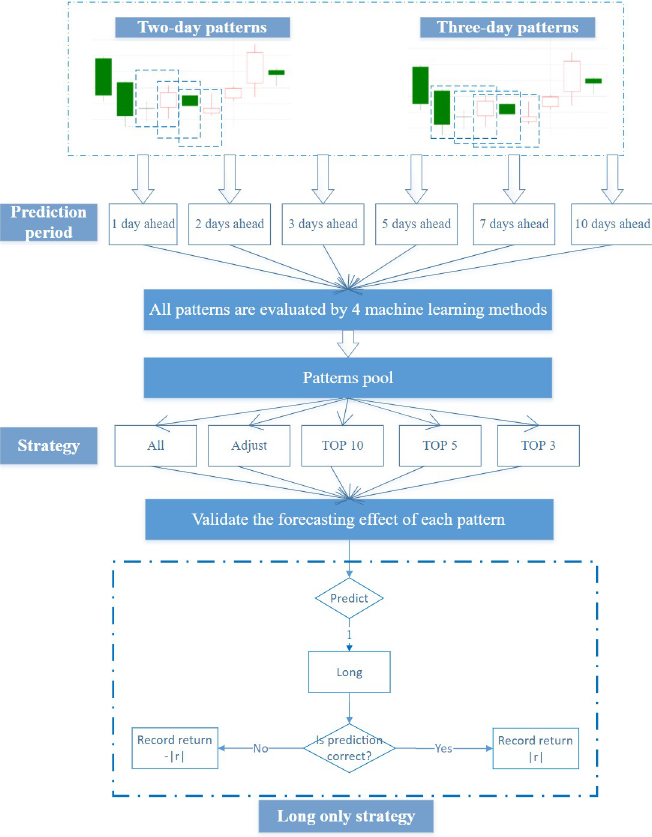
Fig 4. Flowchart of investment strategy construction for two-day patterns and three-day